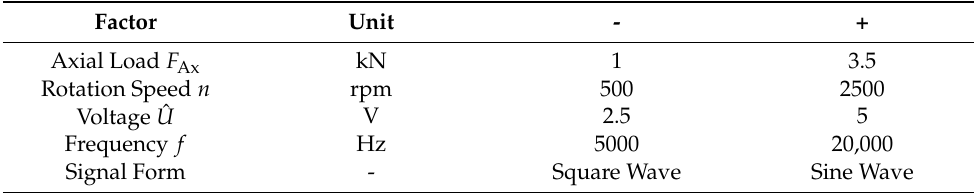
Table 1. Experimental factors.